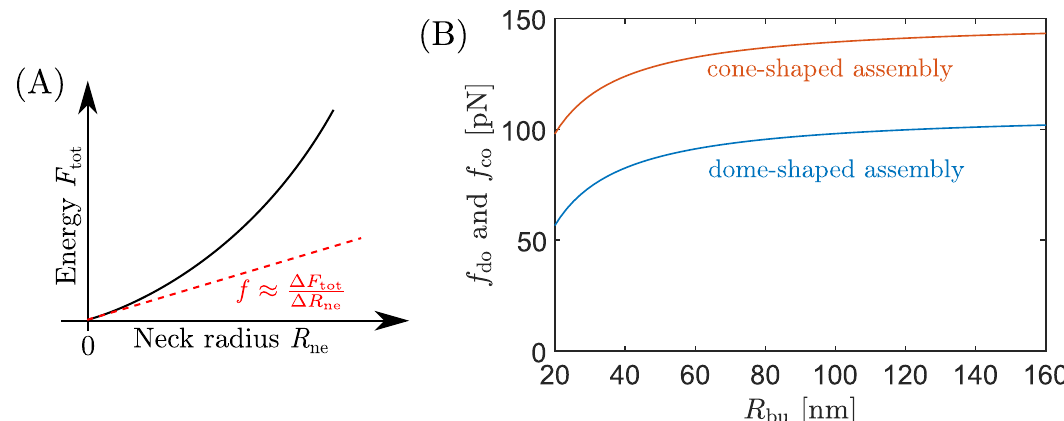
Fig 8. Adhesion-induced constriction forces exerted by the ESCRT complex onto the membrane neck. (A) The constriction force is given by f ¼ @ F =@ R j , with the total free energy as in Eqs 2 and 4 for the dome and cone model, respectively. Thus, opening tot ne R ne ¼ 0 a closed neck by a small amount Δ R ne implies the energetic cost of Δ F tot (cid:25) f Δ R ne . (B) Force as a function of the radius R bu of the bud, for a dome with radius R do = 25 nm (blue line), and for a fully flattened cone (red line). In both cases, the membrane–protein adhesion strength is | W | = 3.45 mN/m. [15] The forces are given by Eqs 15 and 16 for the dome and the cone,